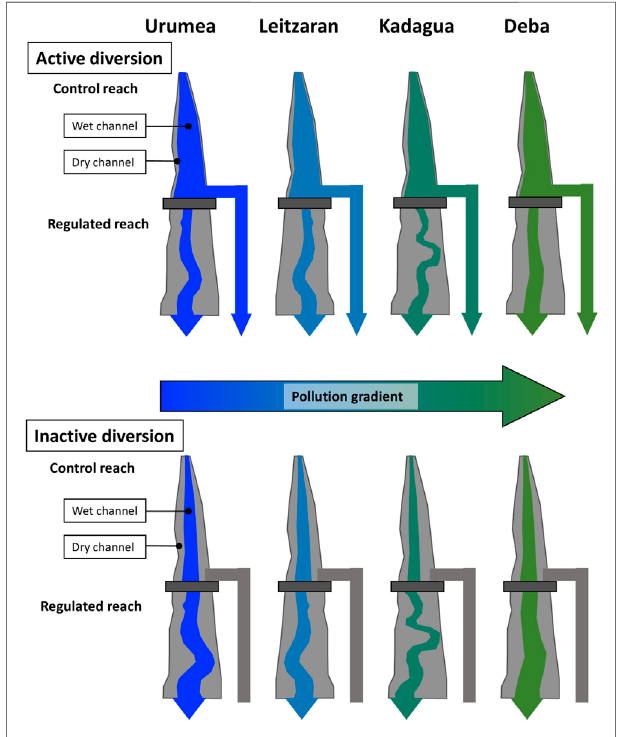
FIGURE 1 | Schematic drawing of the experimental